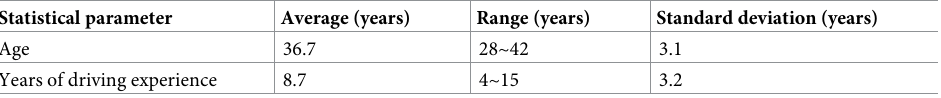
Table 3. General information of